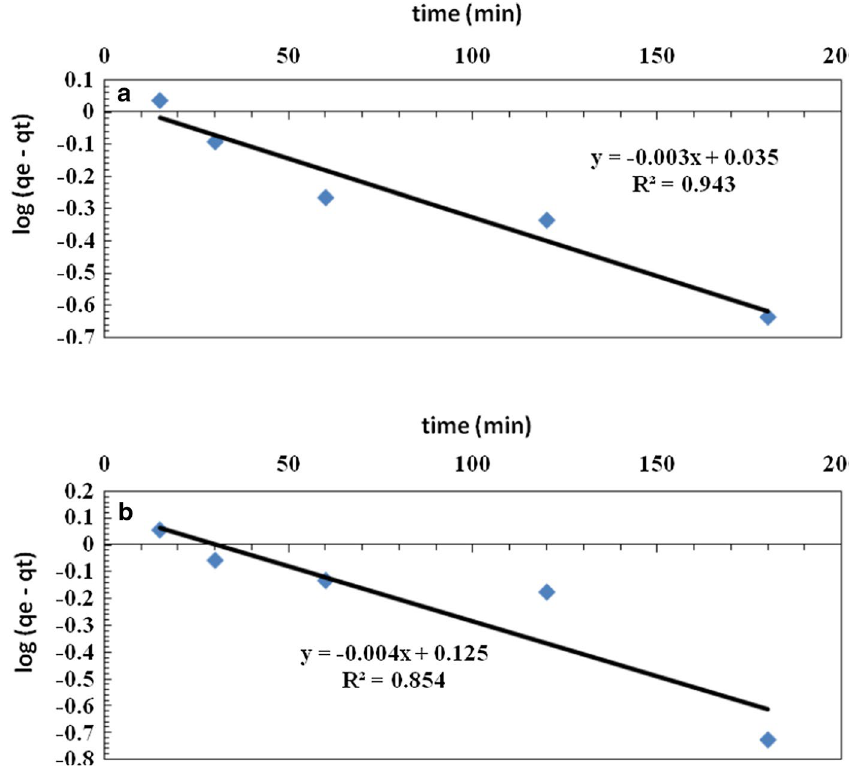
Fig. 7 a and b Pseudo-first- order model for chromium ions removal using 0.5 g/L of a